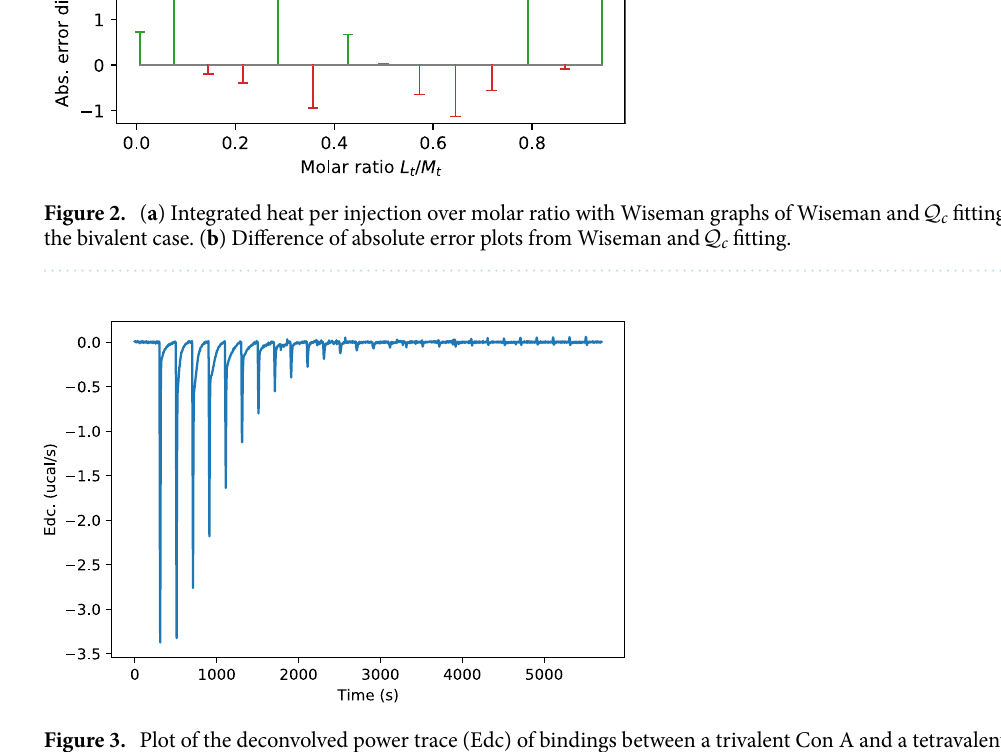
Figure 3. Plot of the deconvolved power trace (Edc) of bindings between a trivalent Con A and a tetravalent precision glycomacromolecule over